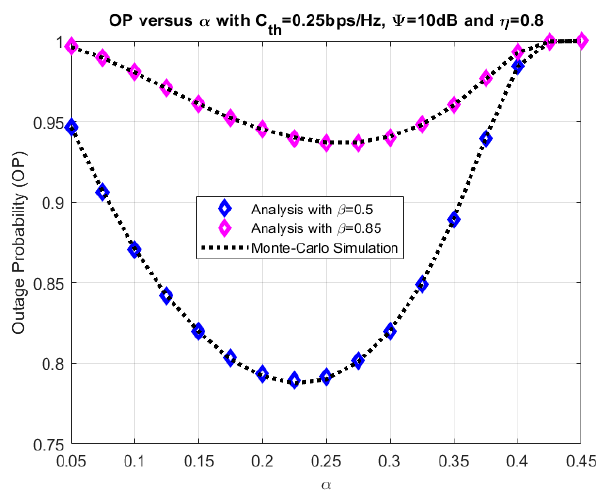
Figure 6. Outage probability (OP) versus α .